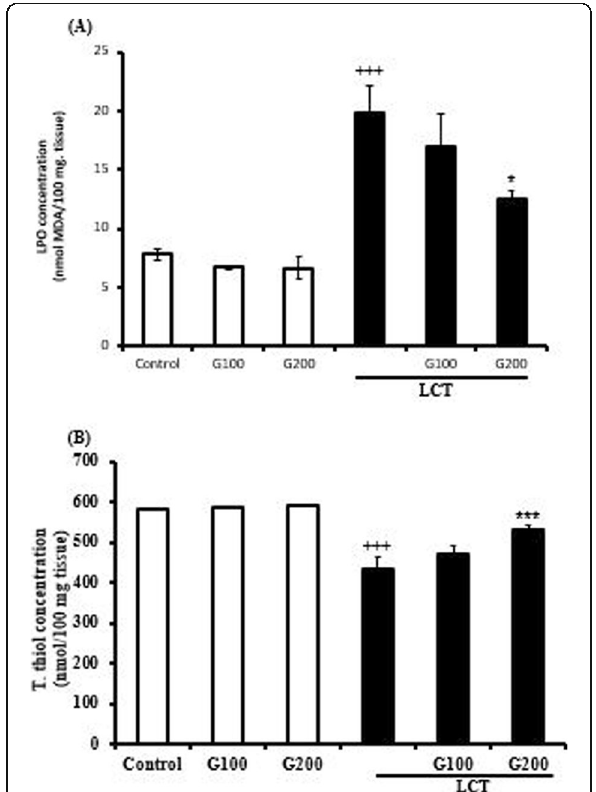
Fig. 3 Effect of Panax ginseng on lambda cyhalotherin-induced changes in liver a lipid peroxidation products (LPO) and b total thiol (T. thiol) concentrations. The results were expressed as mean ± SE ( N = 6). Where G100, 100 mg Panax ginseng ; G200, 200 mg Panax ginseng ; LCT, lambda cyhalotherin administered rats. Values were considered significantly different at +++ P < 0.001 versus control group and * P < 0.05, *** P < 0.001 versus LCT